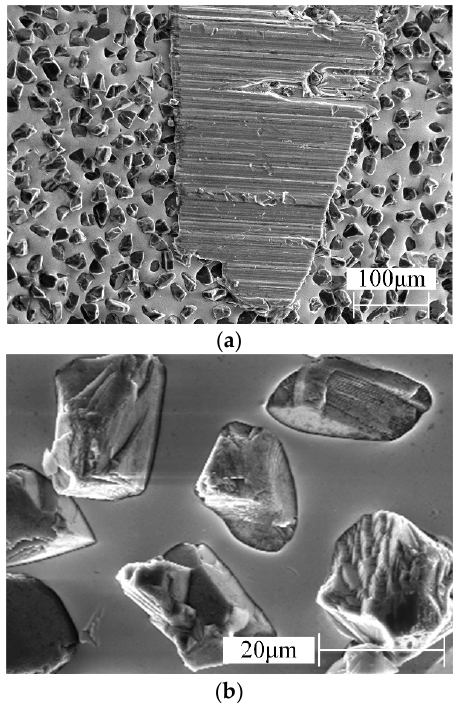
Figure 9. Surface of 600# CBN wheel with wear failure by SEM. ( a ) Morphology of the wheel, ( b ) Abrasive grains on the wheel surface.